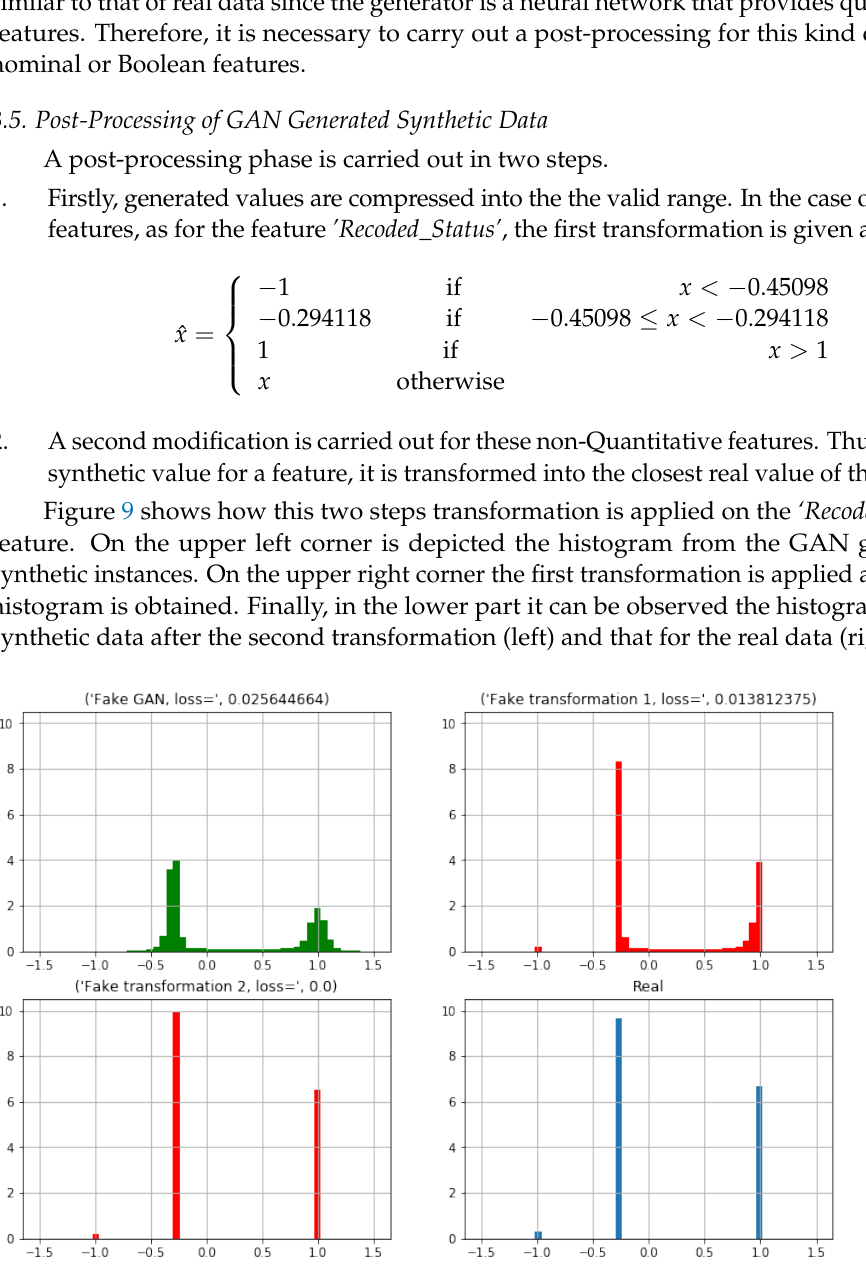
Figure 9. Distribution of the ‘Recoded_Status’ feature from the raw GAN-generated synthetic data (upper left), after the first (upper right) and the second transformation (lower left) and that from the real patients (lower